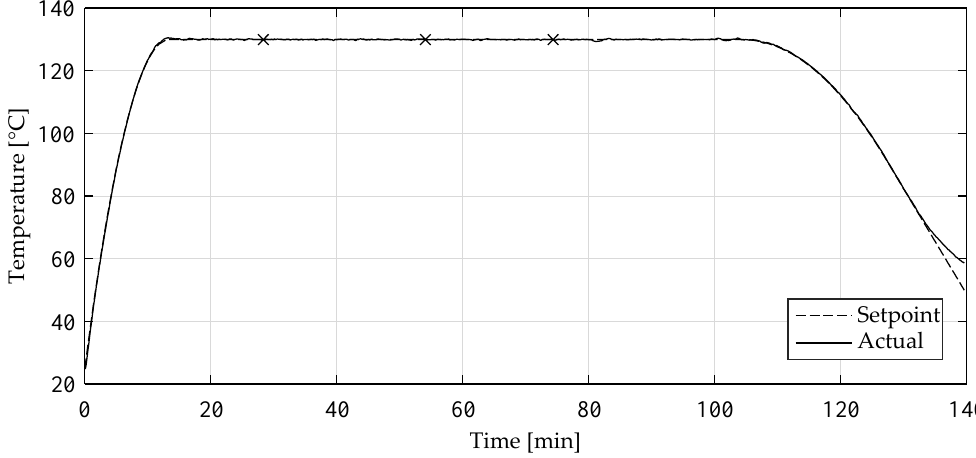
Figure 3. Temperature during the needle injection process.